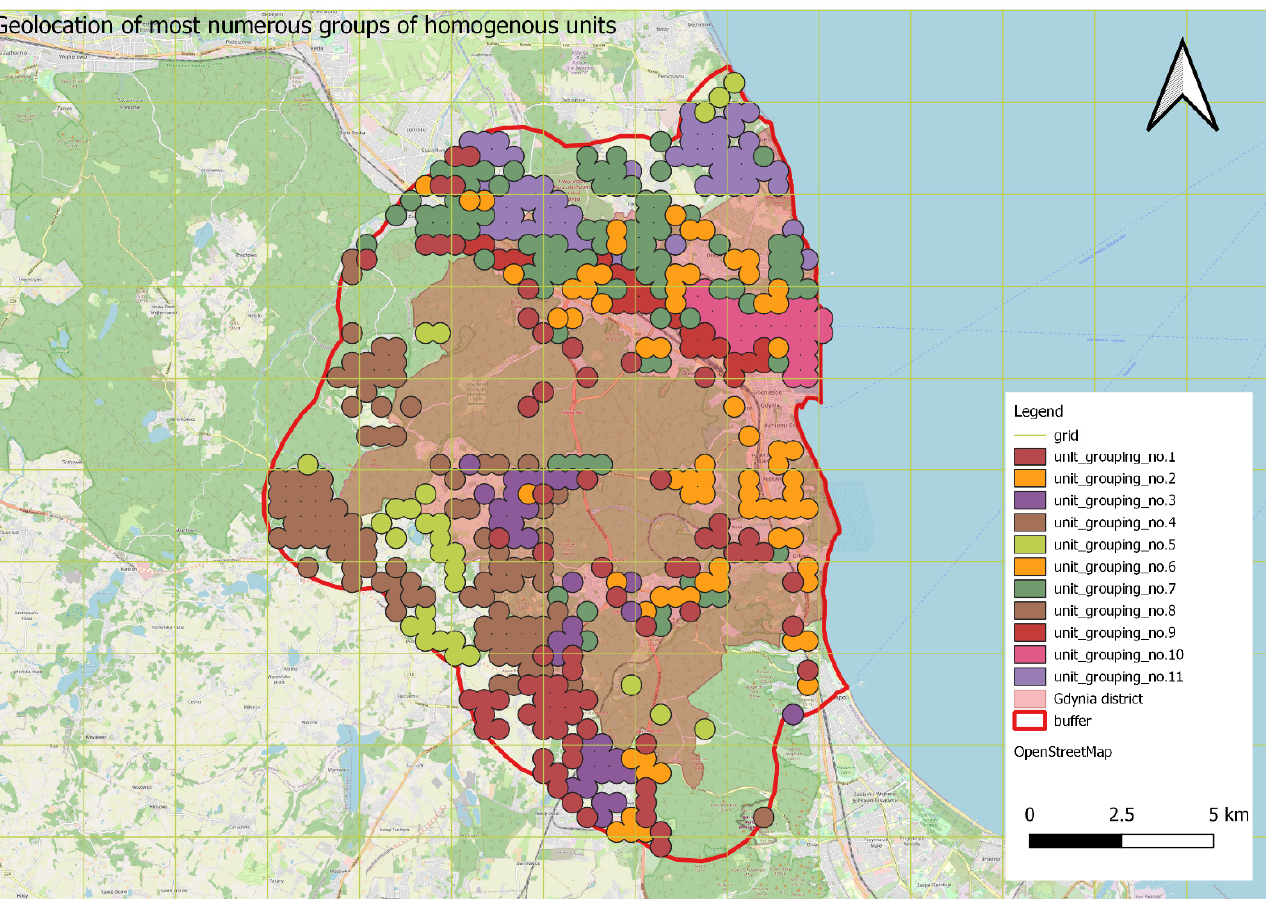
Figure 1. Geolocation of most numerous groups of the homogenous units. Source: based on Renigier-Biłozor, et al. [58].